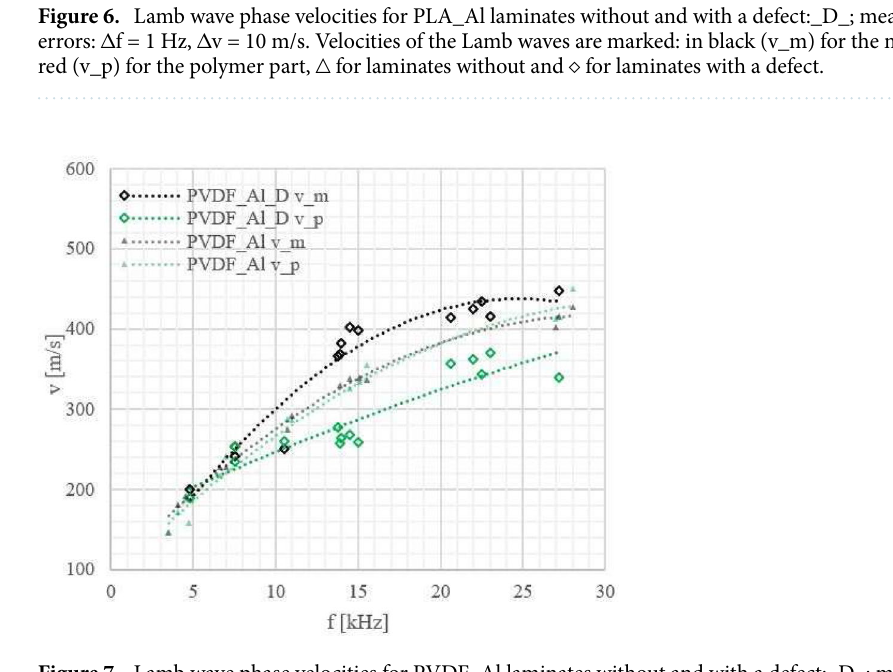
Figure 7. Lamb wave phase velocities for PVDF_Al laminates without and with a defect:_D_; measurement errors: (cid:31) f = 1 Hz, (cid:31) v = 10 m/s. Velocities of the Lamb waves are marked: in black (v_m) for the metal part, in green (v_p) for the polymer part, △ for laminates without and ⋄ for laminates with a